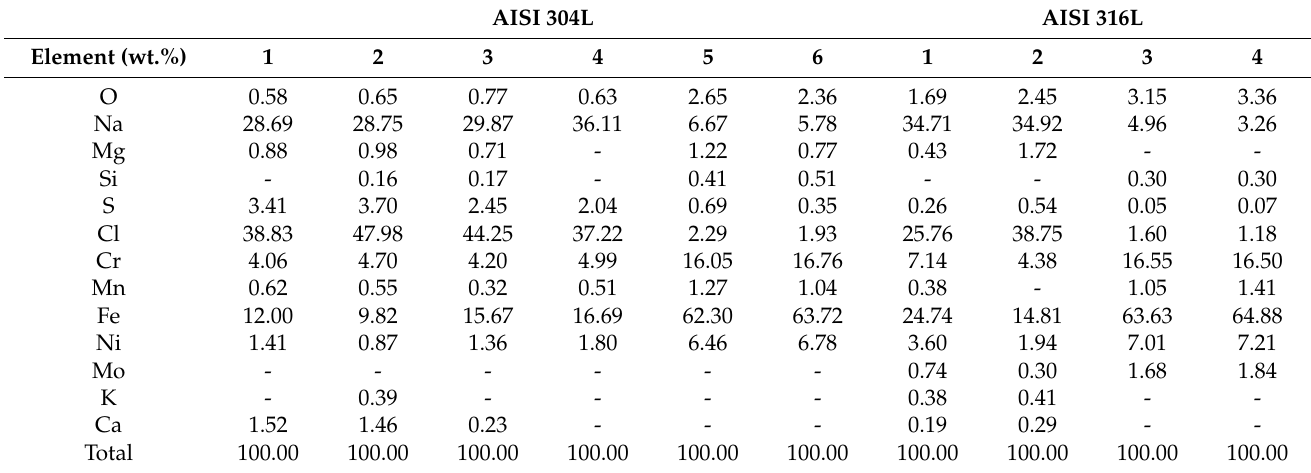
Table 8. Elemental composition on marked parts of the surface of ALSI 304L and AISI 316L steels after potentiodynamic polarization measurements in seawater with 40 ppm S 2 − ions at 298